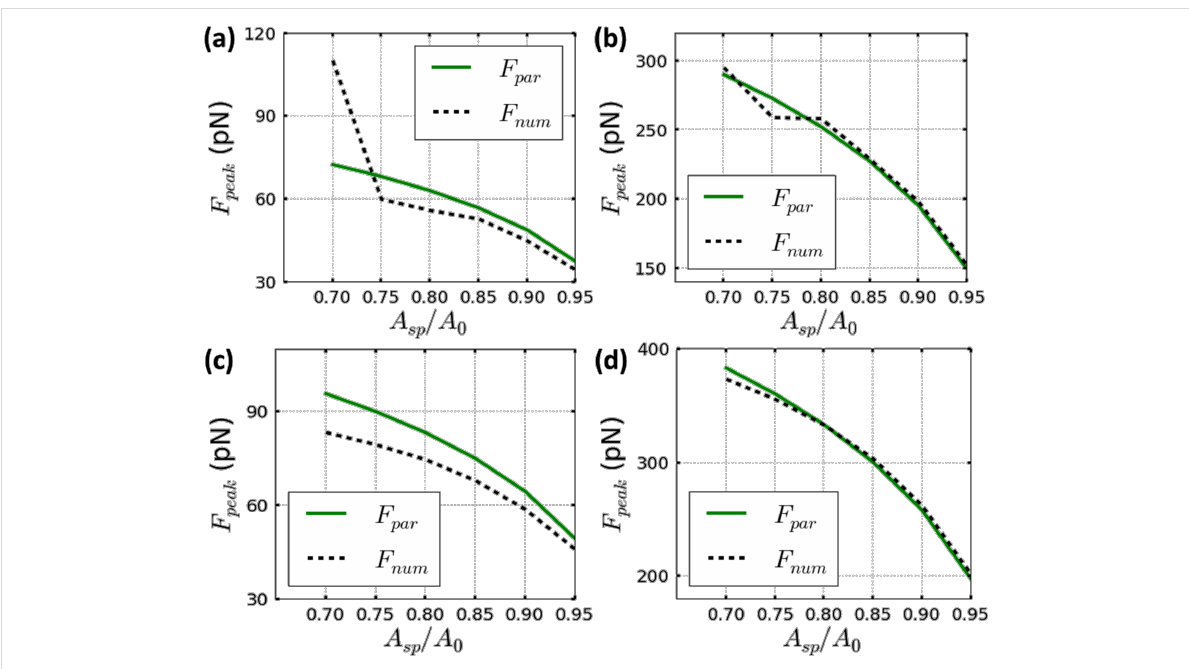
Figure 3: The dependence of the peak forces on the set-point amplitude for the parametrical equation of Equation 8 (full line plots) and the corre- sponding numerical simulations for Tatara’s contact mechanics (dashed line plots). (a) Material with a Young’s modulus of 30 MPa and A 0 = 1 nm. (b) Material with the same Young's modulus as (a) and a higher free amplitude A 0 = 4 nm. (c) Material with a Young’s modulus of 100 MPa and A 0 = 1 nm. (d) Material with the same Young’s modulus as (c) and a higher free amplitude A 0 = 4 nm. Parameters are: Q = 2, k = 0.1 N/m and R t = 5 nm.